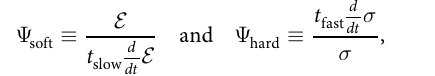
and Ψ  1 soft hard